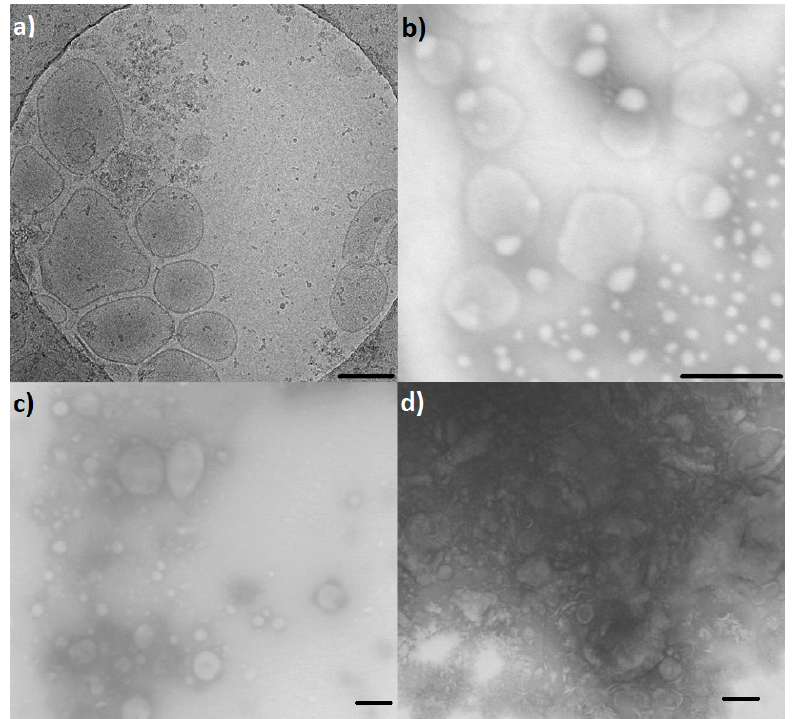
Figure 2. Electron microscopy of EV isolates. ( a ) Cryo-TEM image of N. tabacum PEVs from apoplastic fluid (APF). ( b ) TEM image of N. tabacum PEVs from dried herb. ( c ) TEM image of V. album PEVs from dried herb. ( d ) TEM image of V. minor PEVs from dried herb. Scale bar = 200 nm.